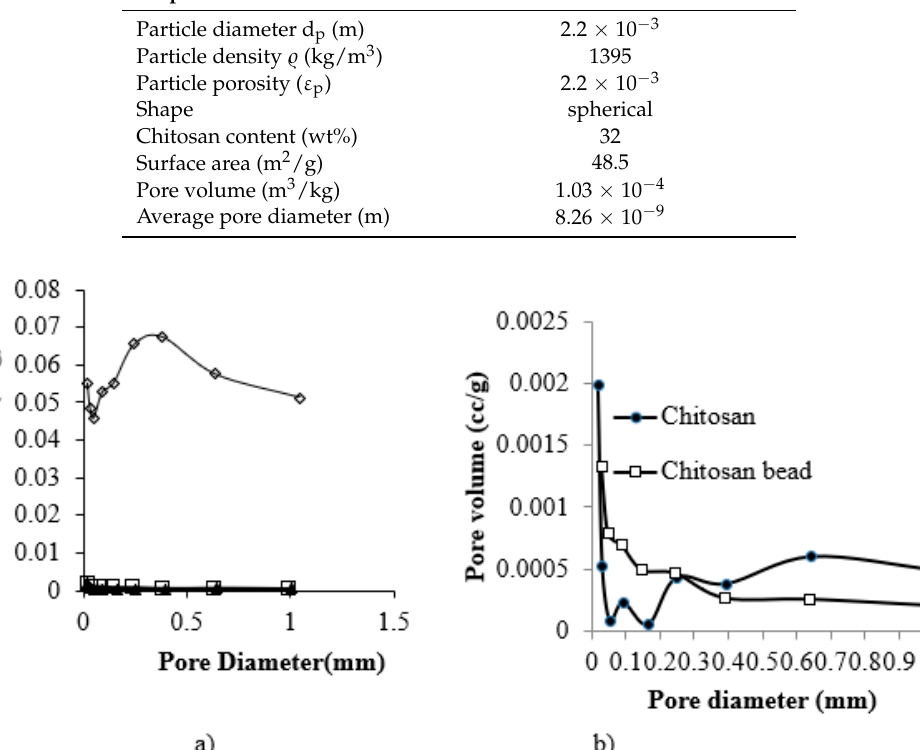
Figure 2. Pore size and pore volume distribution of ( a ) chitosan ( ● ), the pure chitosan beads ( □ ), and the CF beads ( ◊ ), and ( b ) chitosan ( ● ) and the pure chitosan beads only. Table 2. Physical properties of the Fuller’s earth beads.